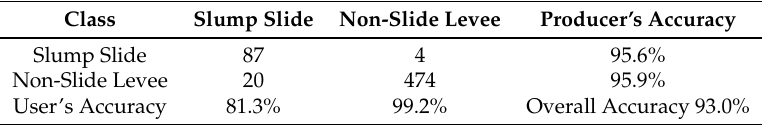
Table 3. Confusion matrix of SVM classifier output using the DWT features with σ = 0.08 and block size B = 8